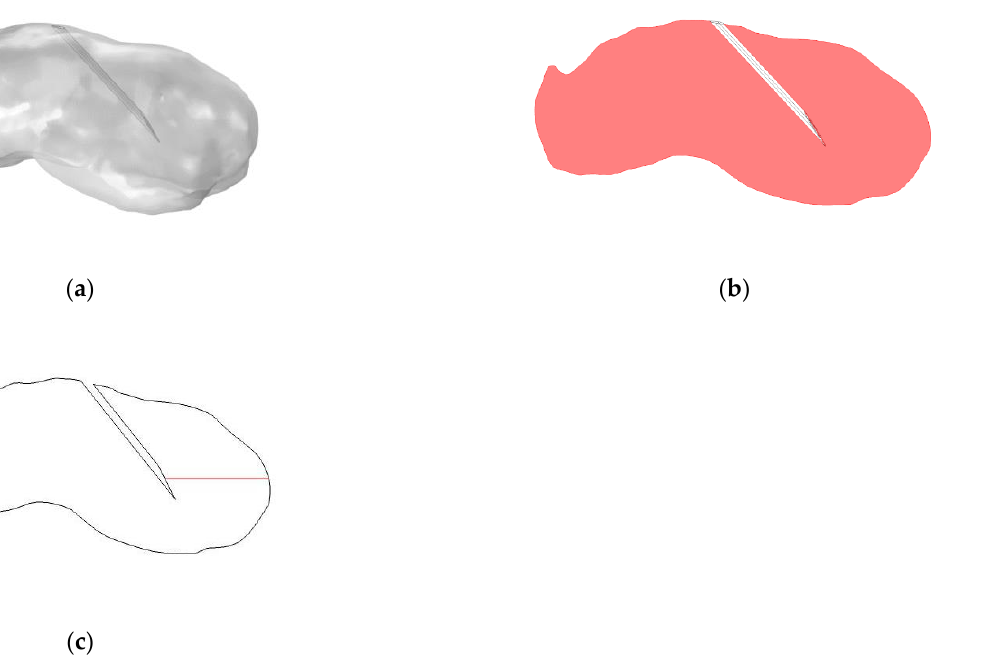
Figure 2. ( a ) Reconstructed FaDu tumour geometry with beveled needle; ( b ) Cut plane through tumour, bisecting the tumour along its long axis; ( c ) Cut line from needle tip to edge of tumour.